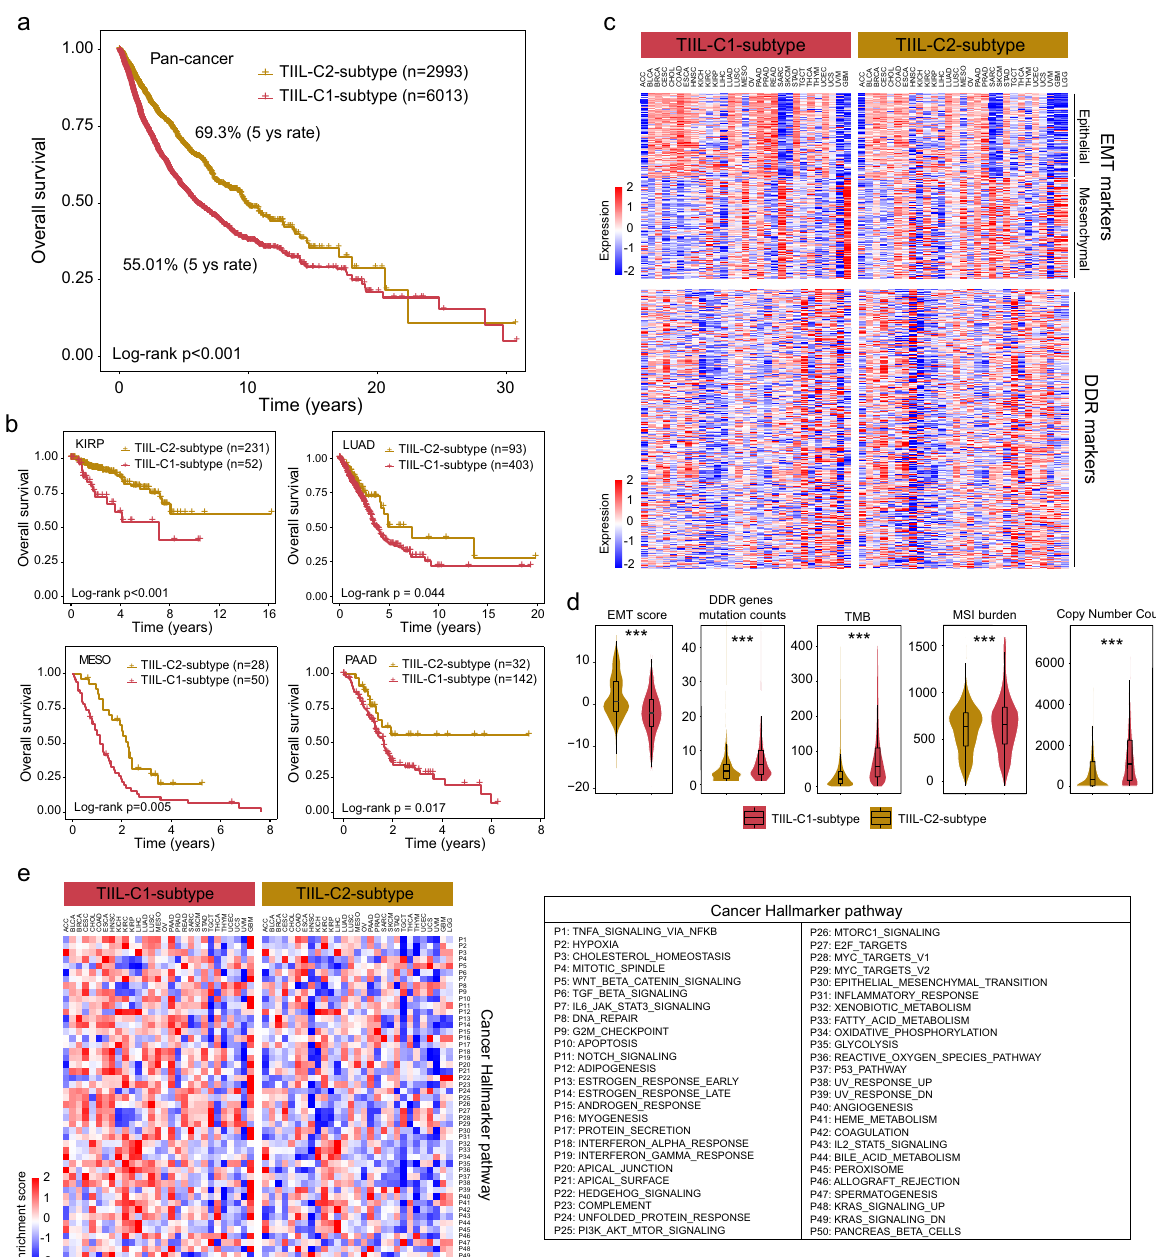
Fig. 2 Biological and clinical heterogeneity across TII-lncRNA-derived pan-cancer subtypes. a Pan-cancer Kaplan – Meier survival curves of tumors in patients with the TIIL-C2 and TIIL-C1 subtypes. The P -value was calculated by the log-rank test. b Kaplan – Meier survival curves of tumor patients with KIRP, LUAD, MESO, and PAAD. The P -value was calculated by the log-rank test. c Heatmap of the expression of EMT and DDR markers between the TIIL-C1 and TIIL-C2 subtypes. d Boxplot for genomic alteration features between the TIIL-C2 and TIIL-C1 subtypes. The P -value was calculated by two-sided Wilcoxon rank-sum tests (*** P < 0.001). e Heatmap of ssGSEA enrichment score of cancer hallmark pathways between the TIIL-C1- and TIIL-C2-subtype. lncRNA long noncoding RNAs, TII-lncRNAs TIME lncRNA modi fi ers, KIRP kidney renal papillary cell carcinoma, LUAD lung adenocarcinoma, MESO mesothelioma, PAAD pancreatic adenocarcinoma, EMT epithelial-mesenchymal transition, DDR DNA Damage Response, ssGSEA single-sample Gene Set Enrichment Analysis. improved survival compared with those with a low TISI (log-rank P was not only associated with intertumoral immune states but also re fl ected oncogenic states, which were predictive of patient < 0.001). Cancer-speci fi c survival analyses also revealed a sig- outcomes. ni fi cant association between the TISI and survival in multiple Therefore, the prognostic signi fi cance of the TISI in predicting cancer types, with a similar prognostic trend observed in the pan- pan-cancer survival was examined. Pan-cancer survival analysis cancer analysis (Fig. 3d). Furthermore, the TISI maintained a revealed that the TISI was signi fi cantly associated with patient signi fi cant association with survival after adjusting other standard survival (HR = 1.627, 95% CI = 1.495 – 1.770, P < 0.001; Fig. 3d). As clinical features in the pan-cancer analysis (Fig. 3e). shown in Fig. 3d, patients with a high TISI had a signi fi cantly Published in partnership with CEGMR, King Abdulaziz